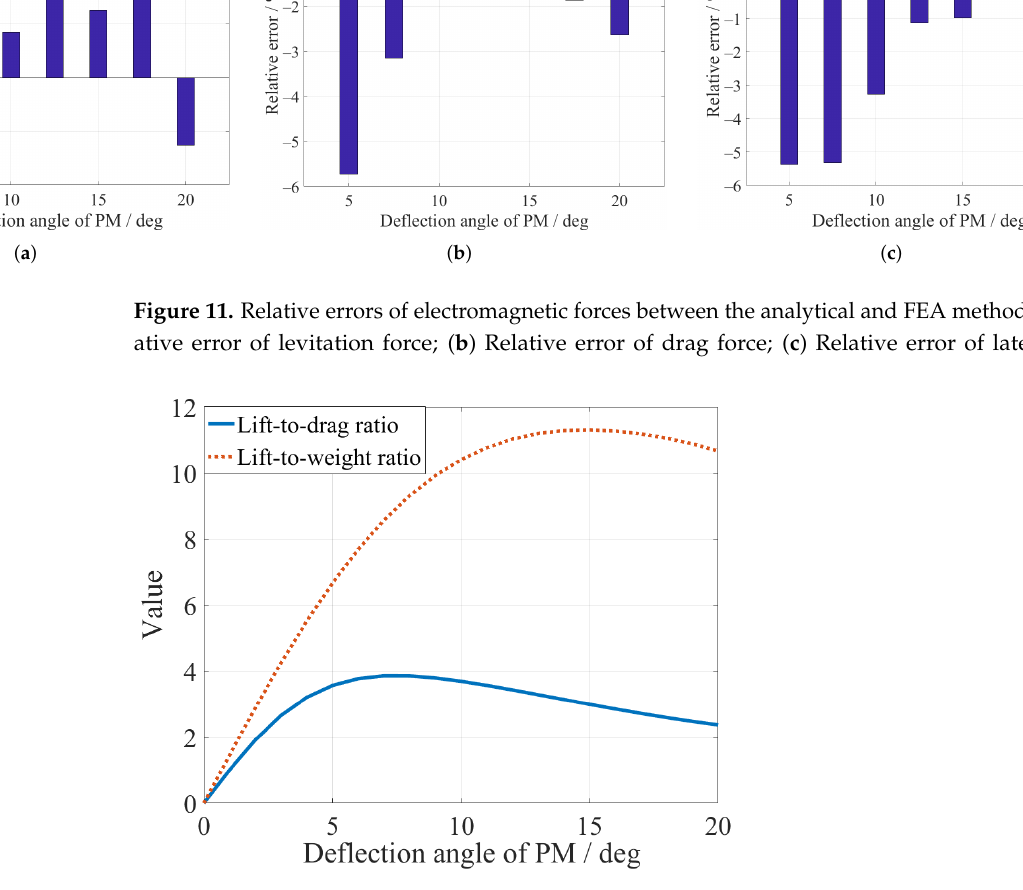
Figure 12. Variations in the lift-to-drag ratio and lift-to-weight